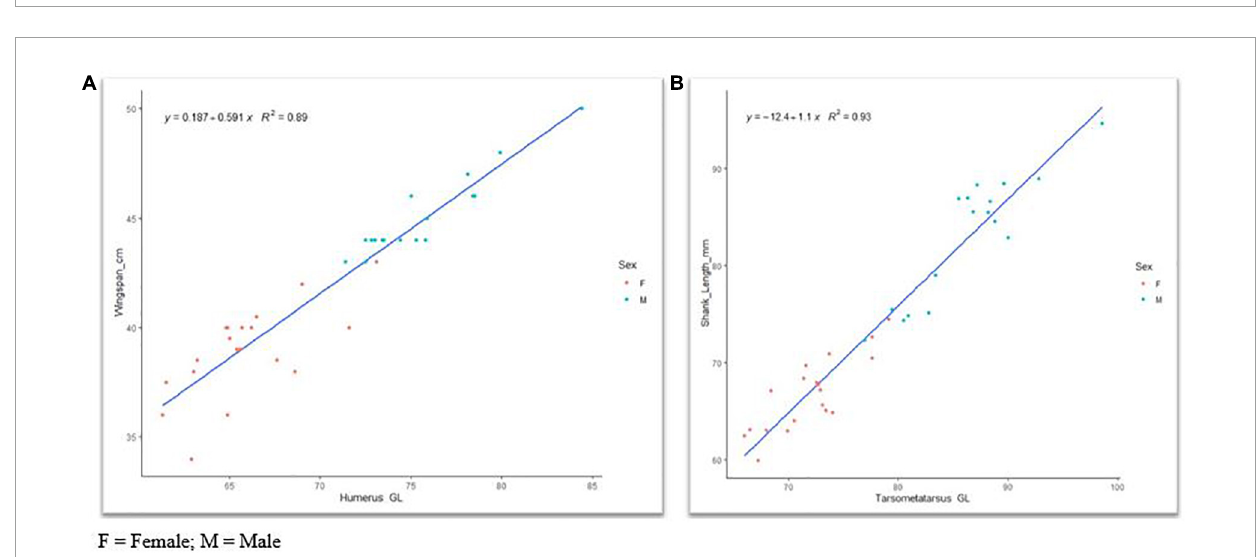
FIGURE5 Linear regression model of (A) wingspan versus humerus and (B) shank length versus tarsometatarsus greatest length. F, female; M, male.